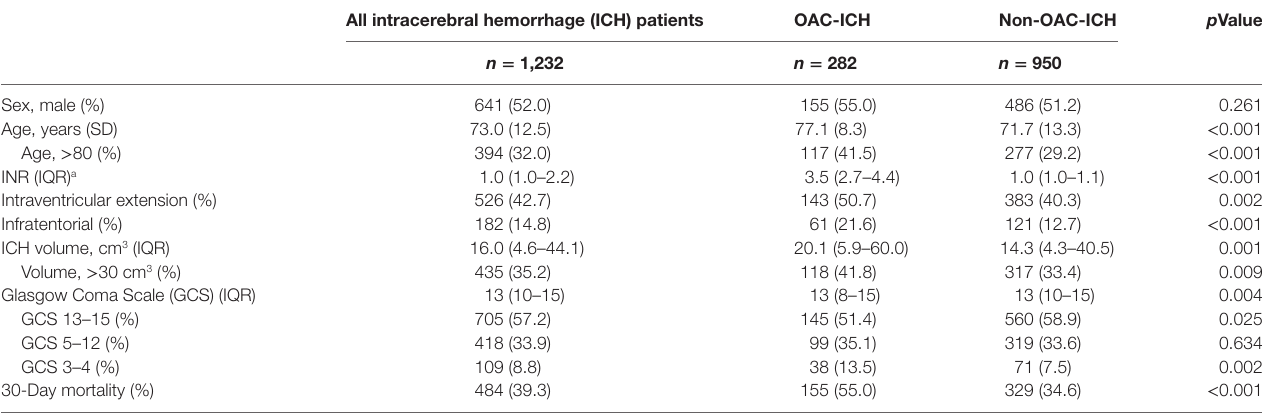
TaBle 1 | Patient